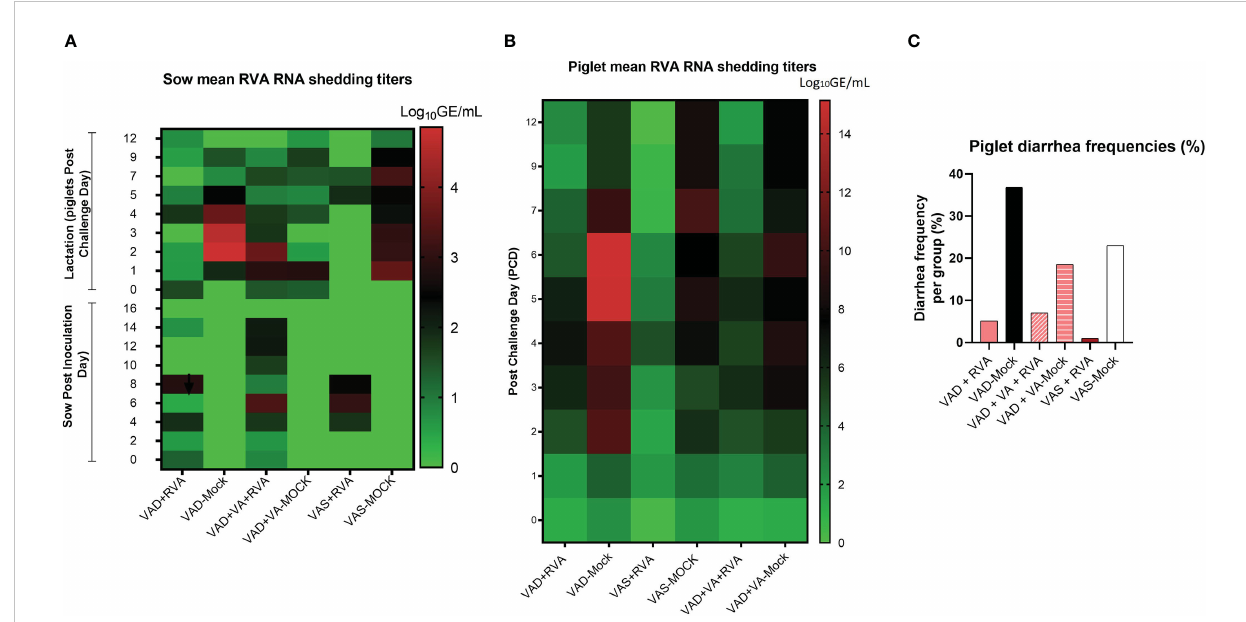
FIGURE 2 Analysis of RVA RNA shedding titers and diarrhea in sows and piglets. RVA OSU strain was used to inoculate sows at gestation day (GD)~90 while piglets were challenged at day post-partum (DDP)~5. RVA RNA titer was determined by RT-qPCR. (A) Heat map showing RVA RNA shedding in sows post sow inoculation (PID0-16) and post-piglet challenge (PCD0-12) expressed as log 10 GE/mL. (B) Heat map depicting RNA shedding in piglets post-piglet challenge (PCD0-12) expressed as log 10 GE/mL. (C) The number of piglets that developed diarrhea per group expressed as a percentage, where fecal scores were scored as follows: 0, normal; 1, pasty; 2, semiliquid; 3, liquid, and diarrhea was considered as score of ≥ 2. Piglets were considered diarrheic if they had a score of ≥ 2 on any day between PCD0 and